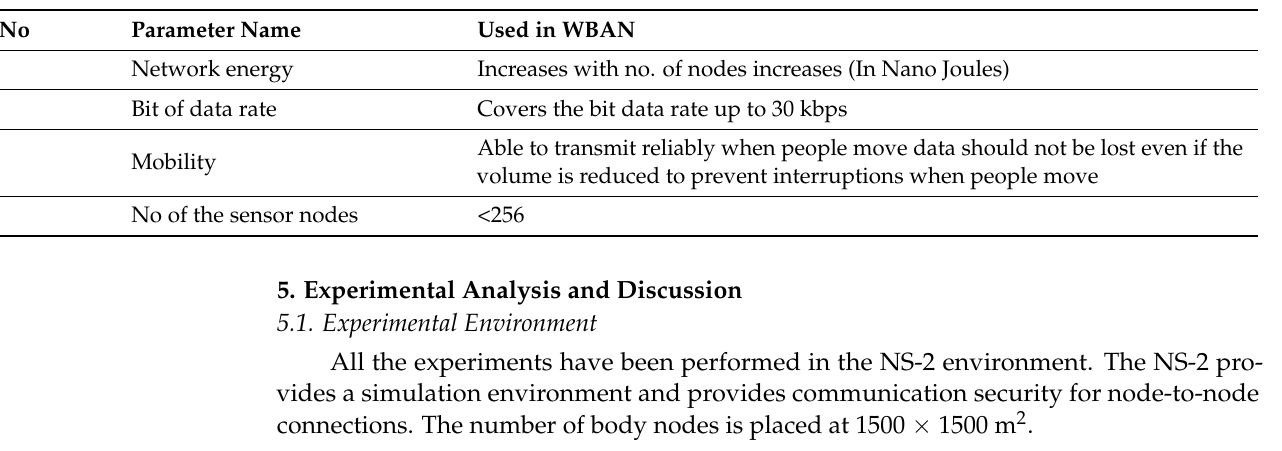
Table 4. QoS specifications for WBAN